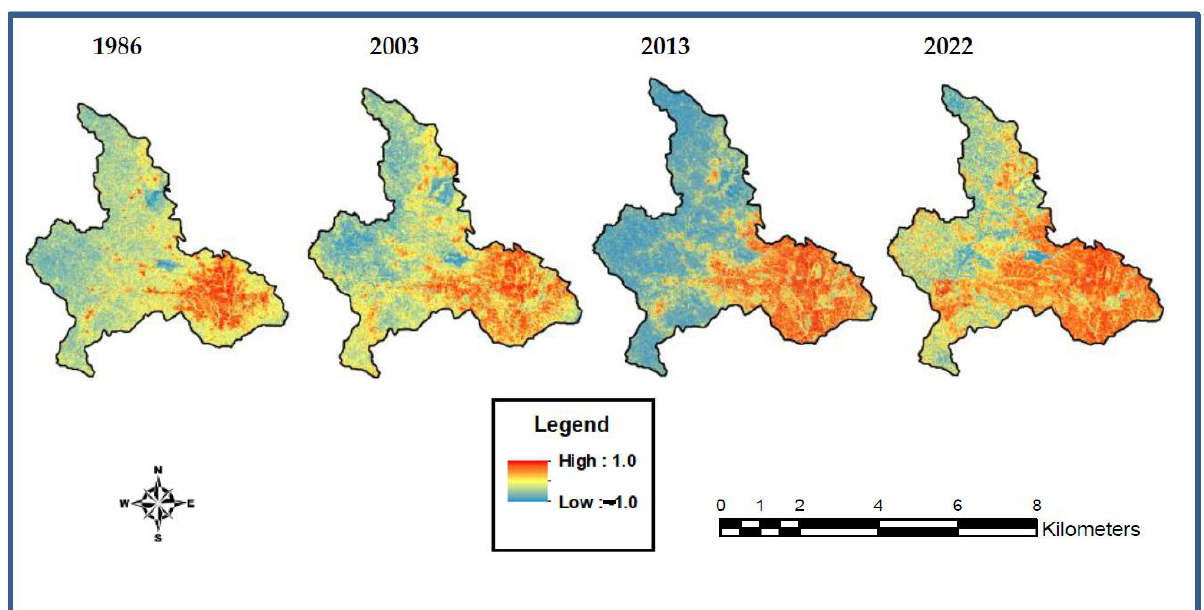
Figure 8. NDBI maps of the study